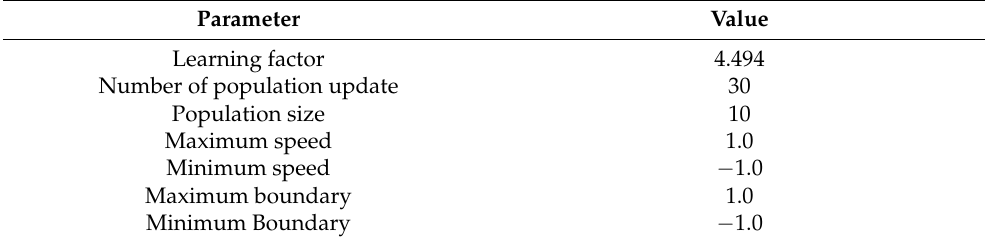
Table 2. PSO optimization algorithm parameters.